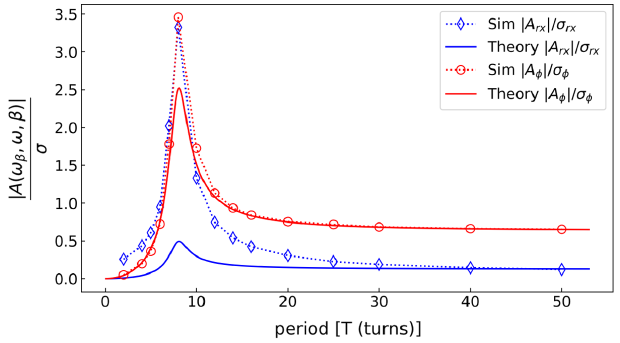
FIG. 10. Plots of normalized amplitude j A ð ω β ; ω ; β Þj with rms size versus misalignment periods in XFELO-A with β ¼ 0 . 1 ; ˆ q ¼ 4 , and crystal tilt amplitude of − 45 nrad obtained from simulations (diamonds for position and circles for angle) and harmonic oscillator model (solid lines, blue for position, and red for angle) of